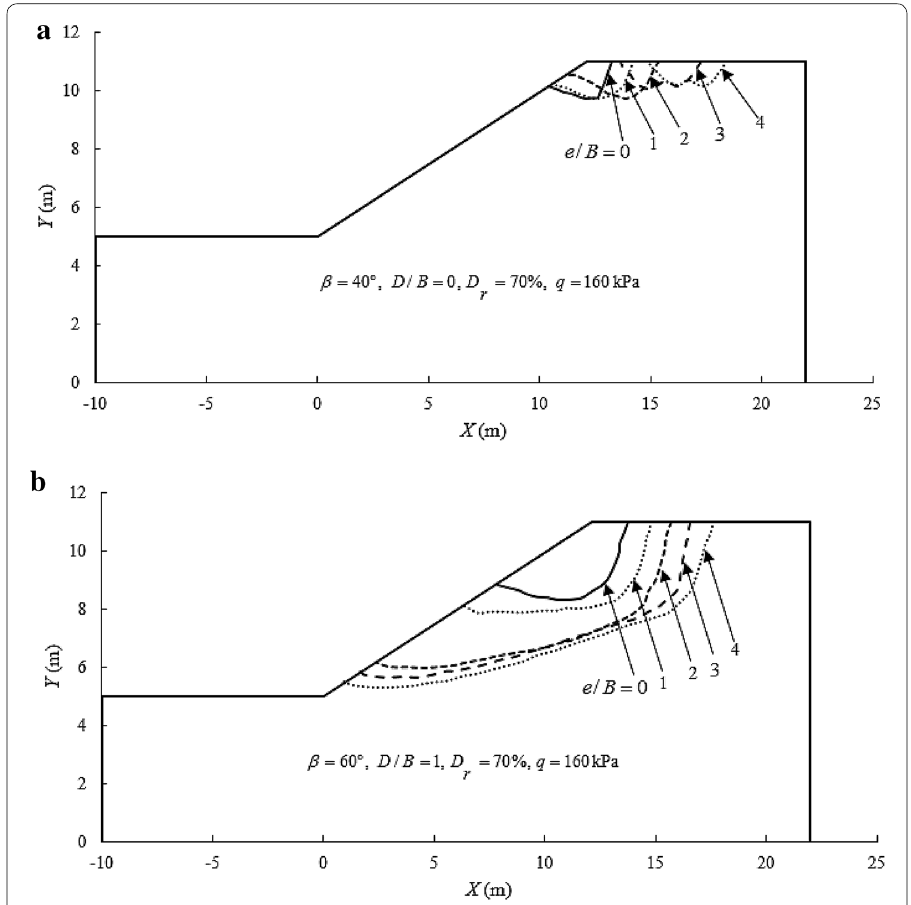
Fig. 11 Slip surface pattern with edge distance ratio, e / B : a D / B = 0 , b D / B =